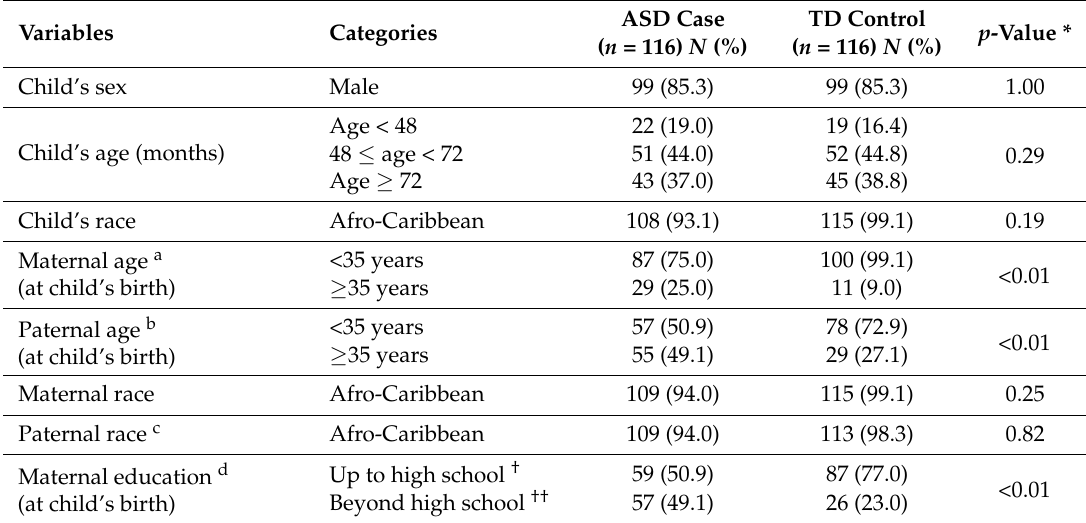
Table 1. Characteristics of children and their parents by ASD case status (116 matched